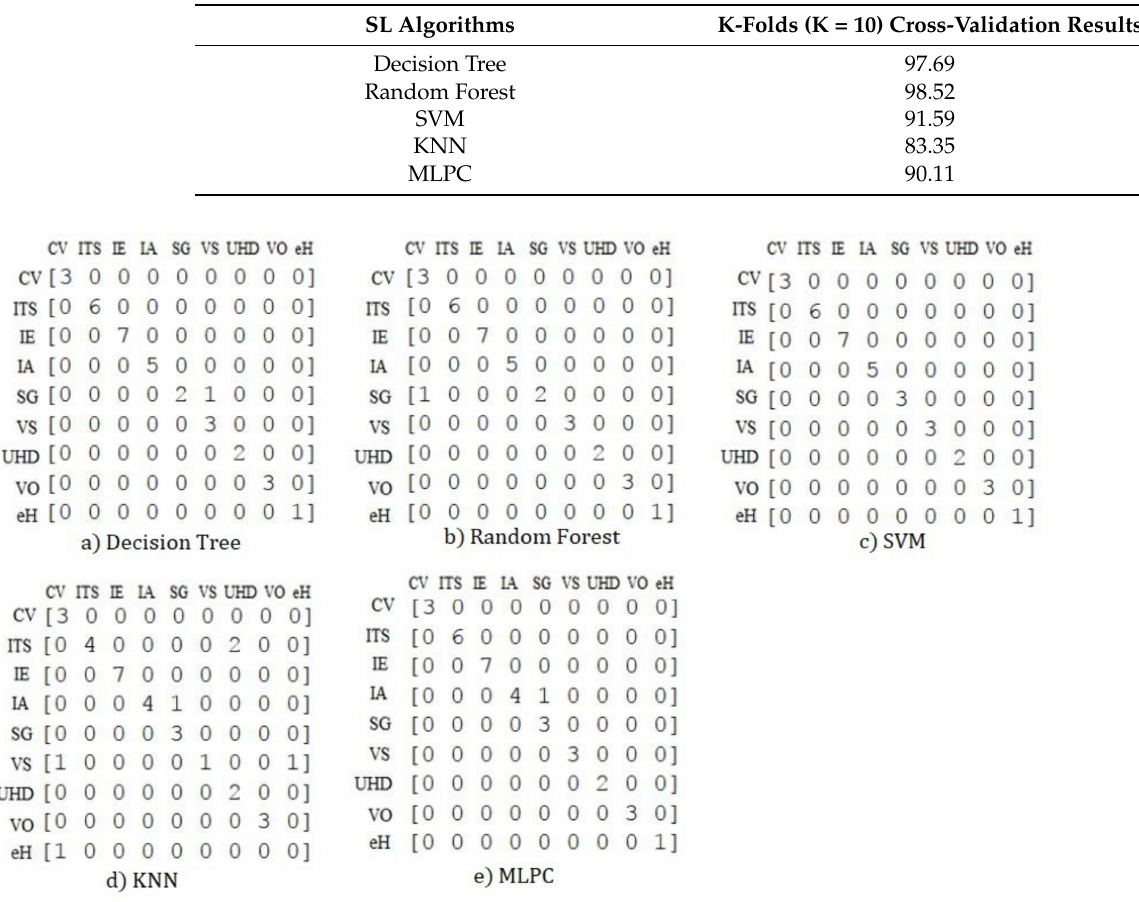
Table 5. Results of the accuracy in cross-validation stage for the second simulation (KPIs + KQIs).